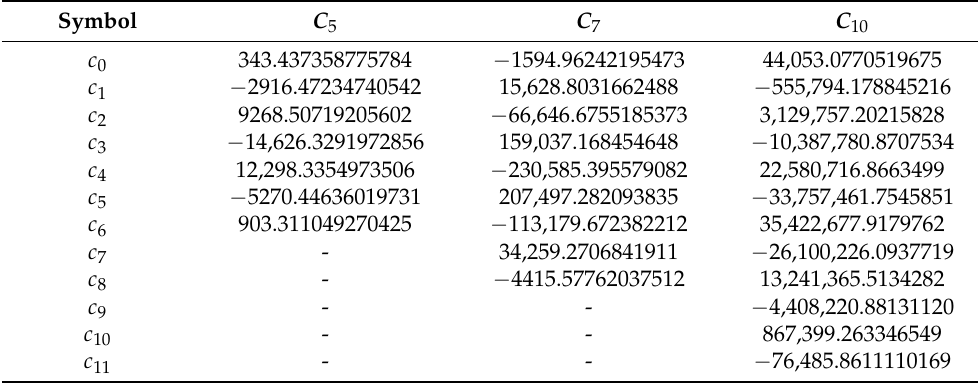
Table A2. The coefficient set when the order of controller is five, seven and ten